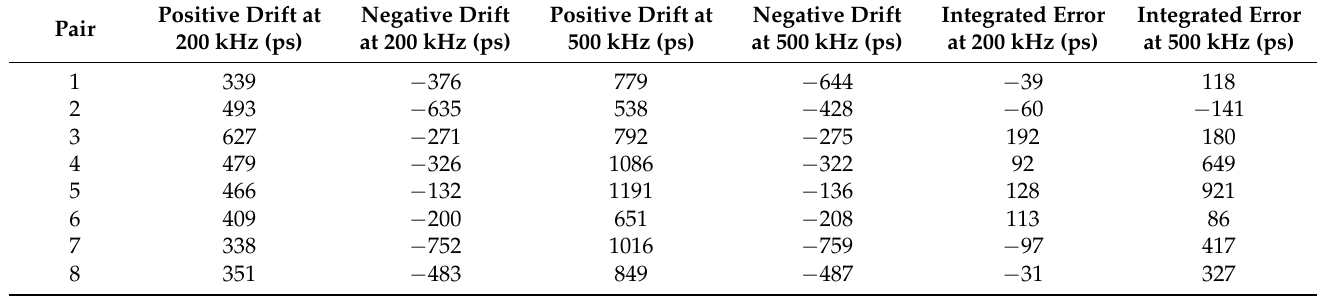
Table 3. Zero-flow drift results.